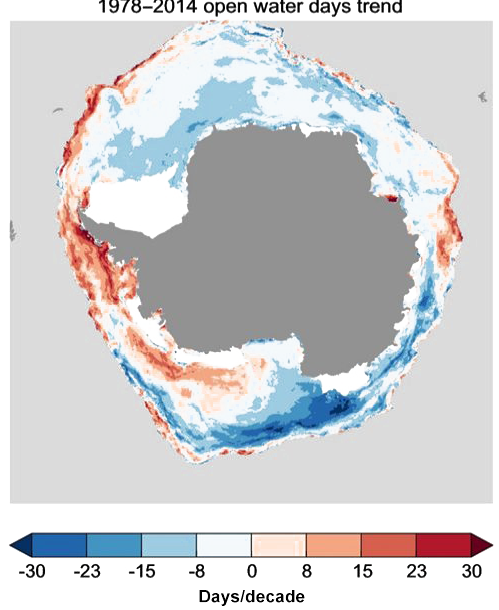
Figure 12. The linear trend in open water days in the Arctic (1978– 2014).